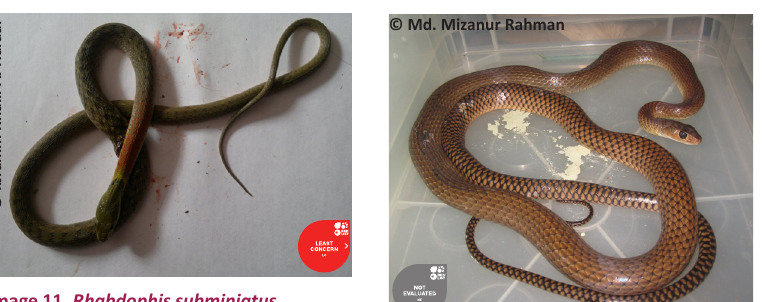
SnakeImage 11. Rhabdophis subminiatus Red-necked